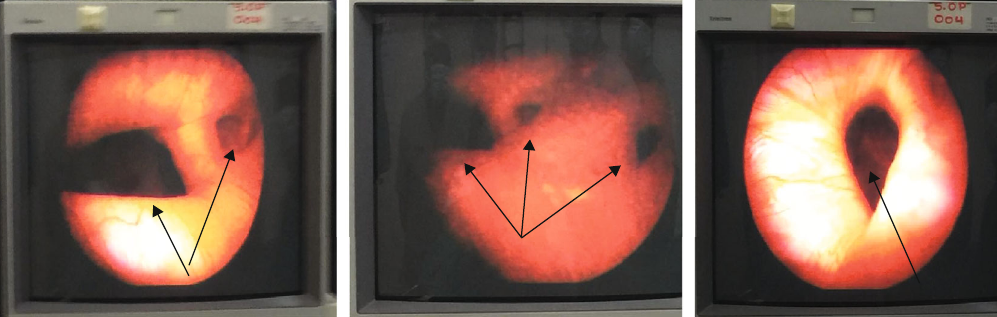
Figure 2: Cystoscopic image of multiple diverticula (black arrow).